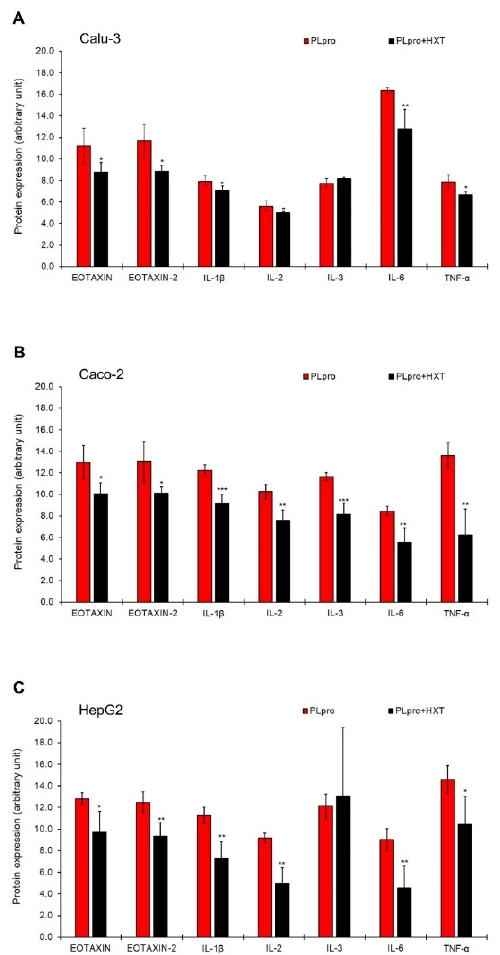
Figure 5. Treatment with HXT down-regulates pro-inflammatory proteins induced by PLpro ex- pression in epithelial cells. Semi-quantitative expression of EOTAXIN, EOTAXIN-2, IL-1 β , IL-2, IL-3, IL-6, and TNF- α in Calu-3 ( A ), Caco-2 ( B ), and HepG2 ( C ) cells expressing PLpro, before and after treatment with 10 µ M HXT for 24 h. Values are plotted as mean ± SD of two independent experiments repeated in duplicate. Data were analyzed by 2-tailed t -tests, * p < 0.05, ** p < 0.01, *** p < 0.001 vs. PLpro.